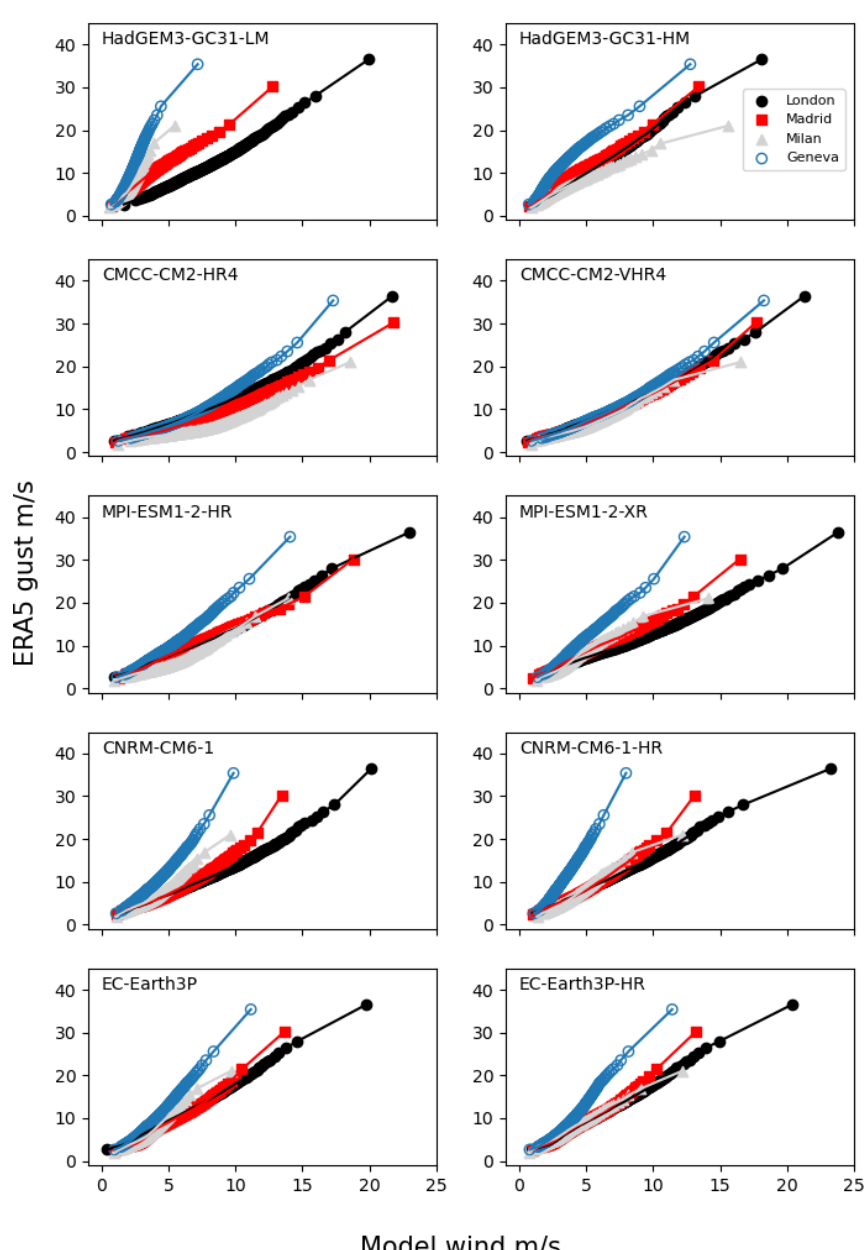
Figure B1. As in Fig. 3 but for the remaining PRIMAVERA